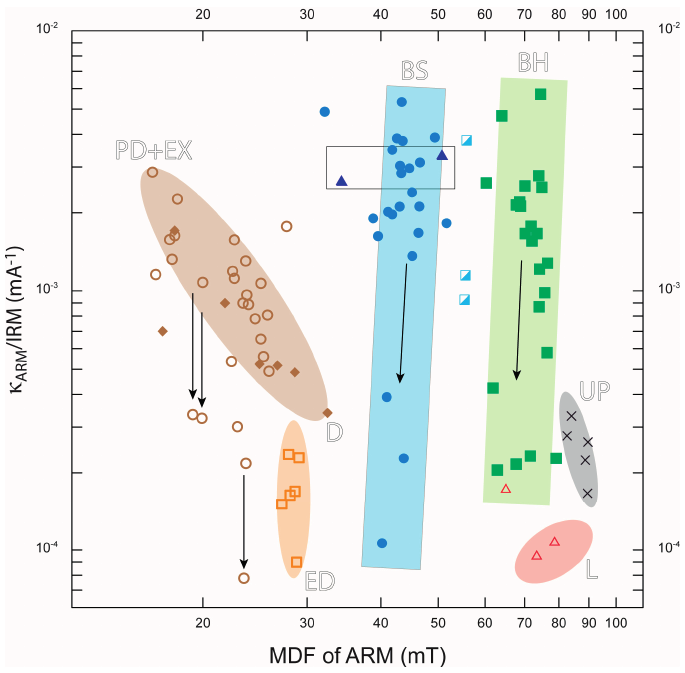
Figure 2. Bi-plot summary of the median destructive field of the Anhysteretic Remanent Magnetization (MDF ARM ) and κ ARM /IRM clusters for different magnetic components as identified by Egli [50]. Letters classify and discriminate the different components into low-coercivity magnetosomes (biogenic soft, BS: blue dots and rectangle), high-coercivity magnetosomes (biogenic hard, BH: green squares and rectangle), ultra-fine extra cellular magnetite (EX: brown circles), pedogenic magnetite (PD: brown diamonds) and fluvially transported detrital particles (D: brown diamonds and brown ellipse), wind-blown particles (eolian dust, ED: orange squares), urban pollution particulate matter (UP: black crosses and ellipse), and maghemite in loess (L: red triangles and ellipse). The open rectangle intersecting BS relates to cultured magnetotactic bacteria (blue triangles); magnetosomes with intermediate coercivity fall between BS and BH clusters (open light blue half-filled squares). Arrows indicate the decrease of κ ARM /IRM observed during anoxic lake sediment conditions. All data redrawn from Egli